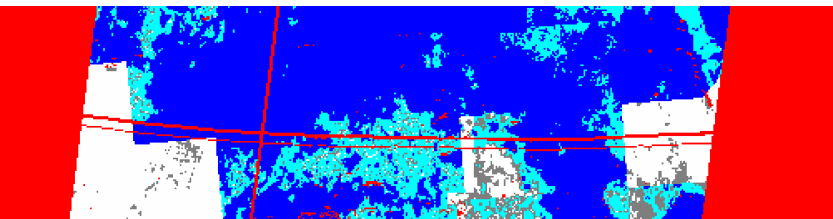
Figure 16. Map of the original RCCM for Path 169, Orbit 78171, Block 102 and camera DA. Linear dimensions are as described in the caption of Fig. 3, while color coding is identical to that indicated in Fig. 9. This scene contains two curved lines of missing data across-track and one straight line of missing data along-track. The cloud mask exhibits clear rectangular tiles which are the result of small changes in the dynamically determined thresholds used to classify the cloudiness level of the